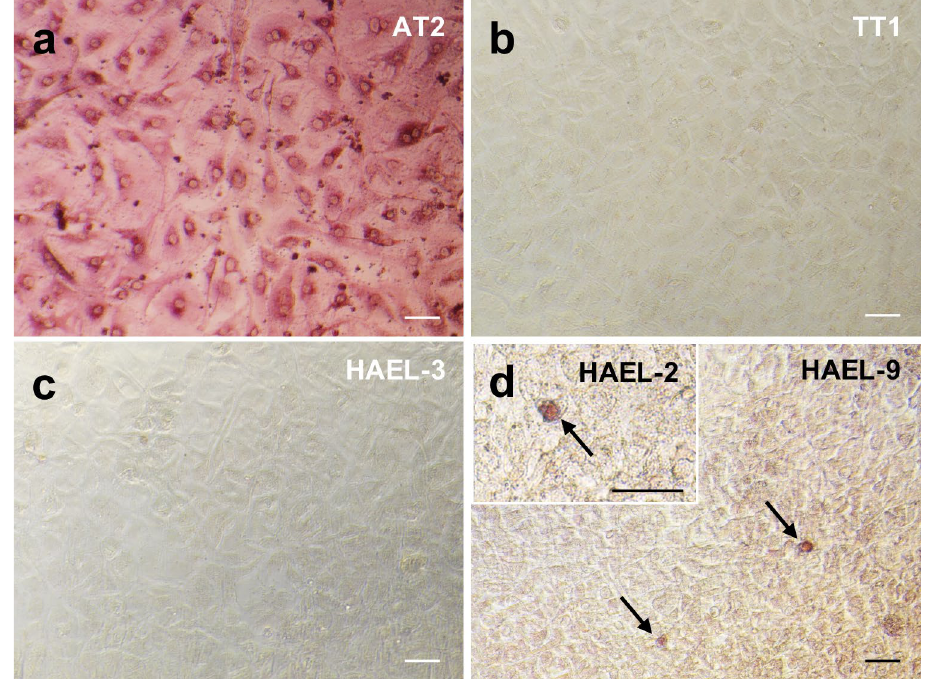
Figure 5. Alkaline phosphatase staining showing AP-positive AT2 cells ( a ) and negative TT1 cells ( b ). Some ICs were AP-negative ( c ) whereas others were mostly AP-negative showing scattered AP-positive cells (arrows) ( d ). Bars = 50